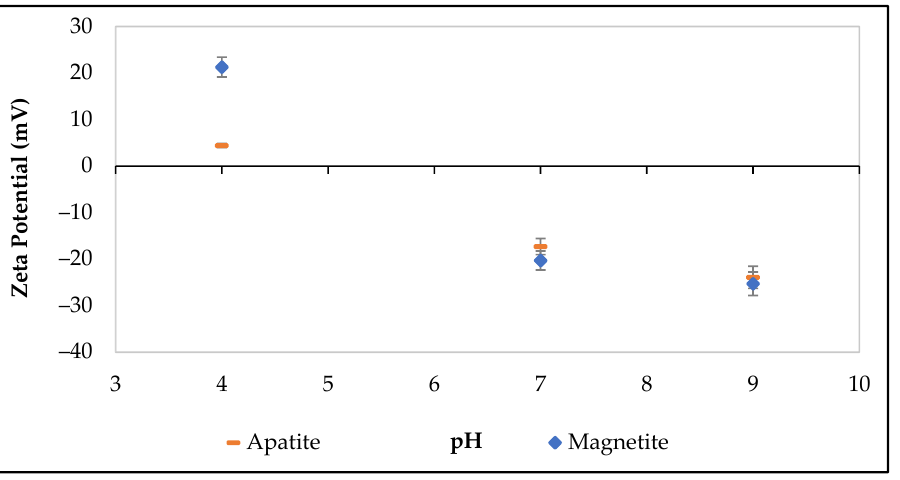
Figure 3. Zeta Potential measurements for apatite and magnetite suspensions at pH 4, 7, and 9.